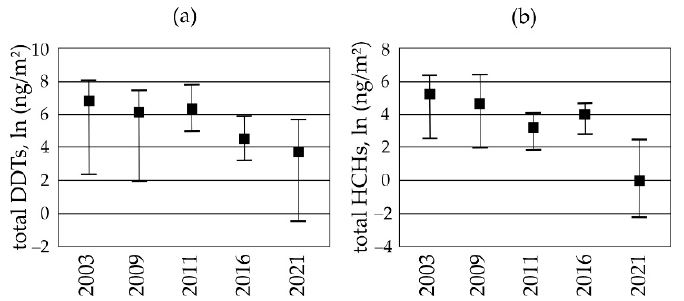
Figure 7. Comparison of total DDT ( a ) and HCH ( b ) levels in snow in 2003–2021 (ln (ng/m 2 ))